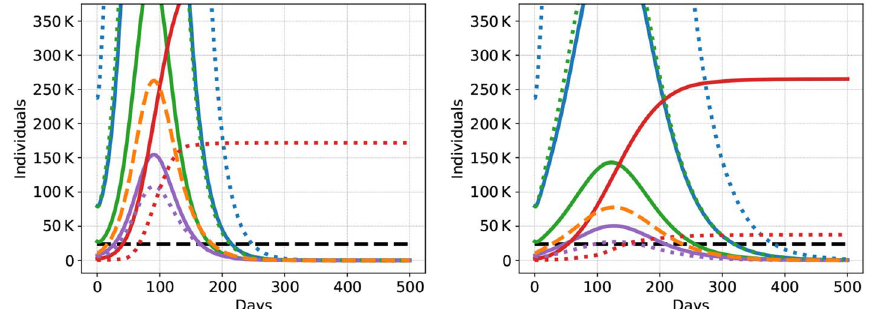
Figure 2. Dynamics of the COVID-19 epidemic for scenario B2-Trace with low (20 % ) compliance by both groups (ll, left) and with mixed (20 % by group H and 80 % by group L) compliance (hl, right): Symptomatic individuals (traced and not traced added together) in blue, asymptomatic in green, severe cases in purple, overall severe cases (H and L group aggregated) in orange, dead in red, and ICU capacity in black. The group with low vulnerability has dotted curves, the group with high vulnerability is plotted